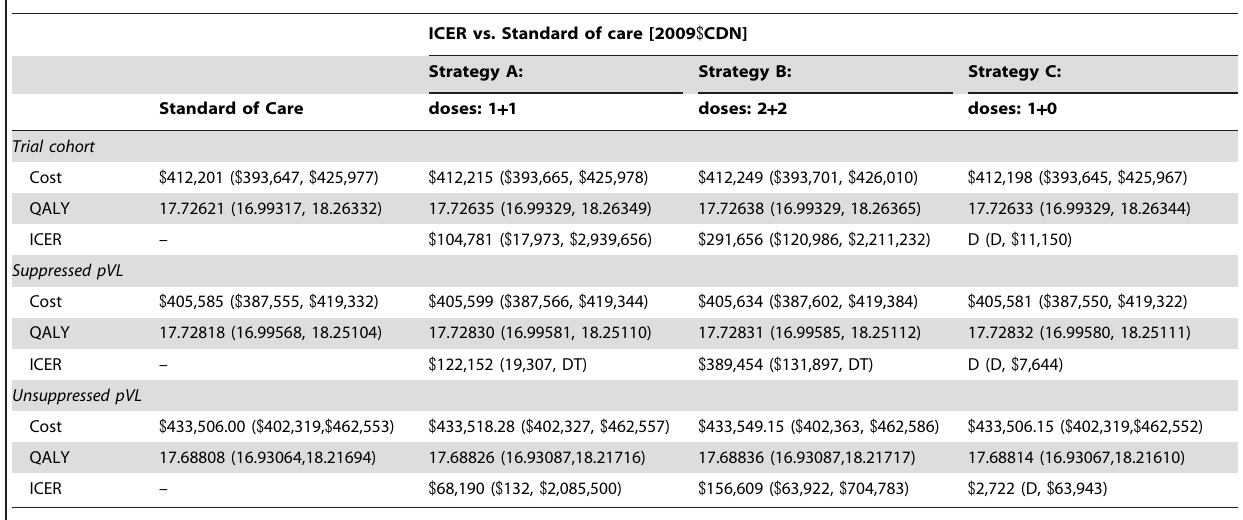
Table 4. Incremental costs per quality-adjusted life year gained: strategies A vs. Standard of Care.